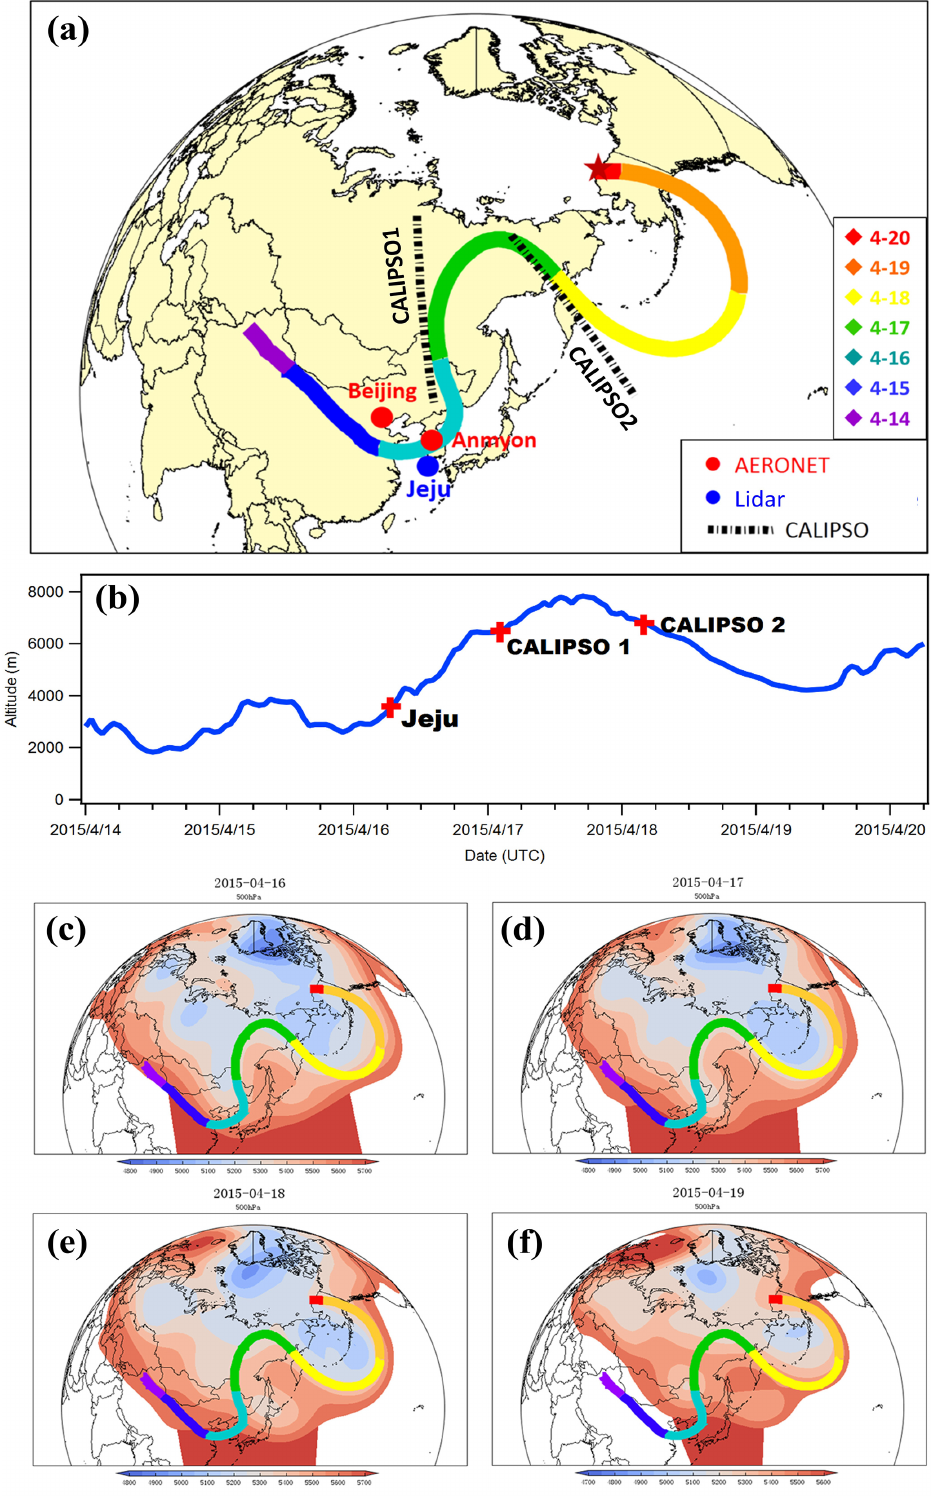
Figure 4. (a) The 7d backward trajectory simulated at an altitude of 6km above Barrow starting from 04:00UTC on 20 April 2015. The locations of AERONET, lidar sites, and CALIPSO tracks near the trajectory are plotted. (b) The height of the trajectory along the transport path. The height and time of dust layers observed by lidars and CALIPSO in Fig. 4a are indicated by the red plus symbols. (c–f) Daily geopotential height fields (500hPa) from the NCEP reanalysis